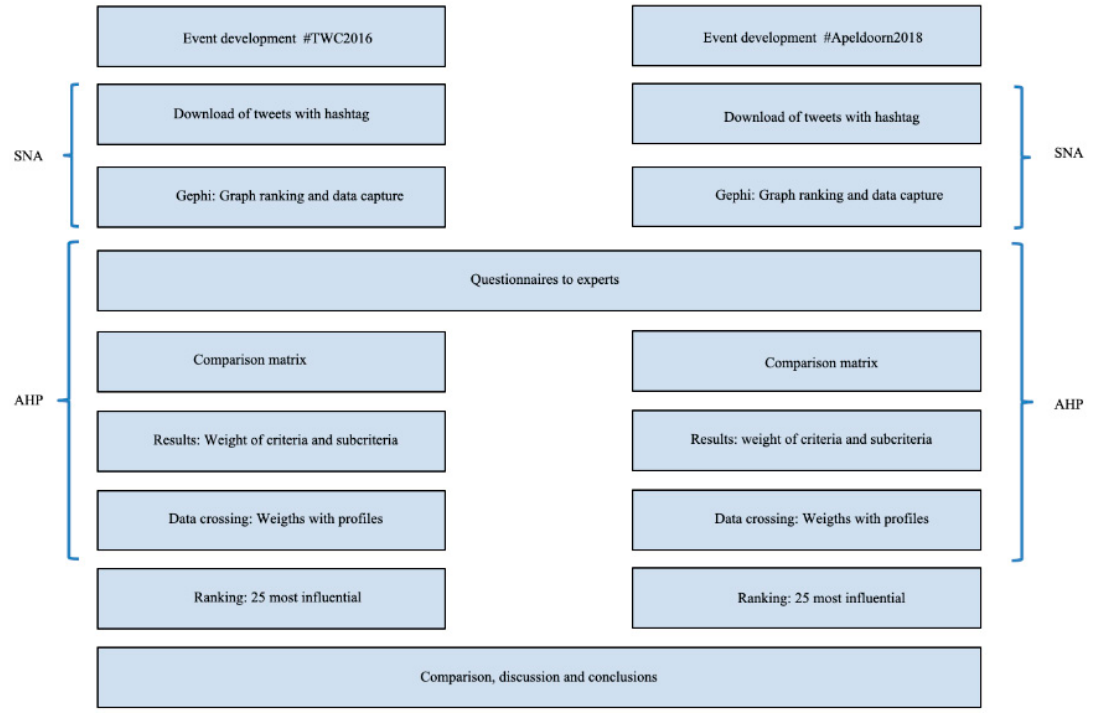
Figure 1. Detail of the steps carried out for the research in the two events.